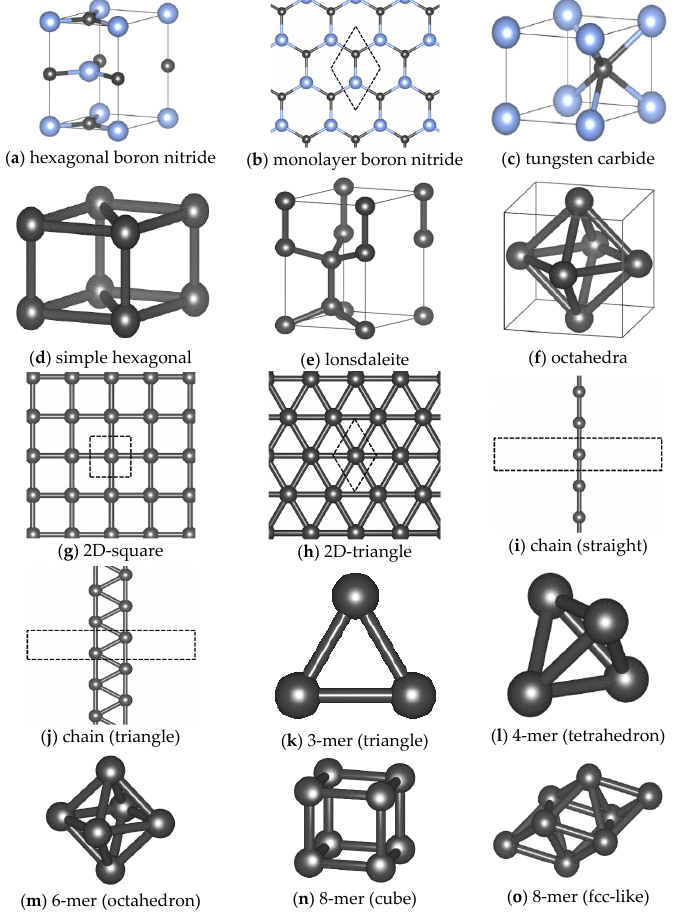
Figure A1. Atomic structures (untypical) used as reference structure. Thin solid and dashed lines indicate the unit cells.